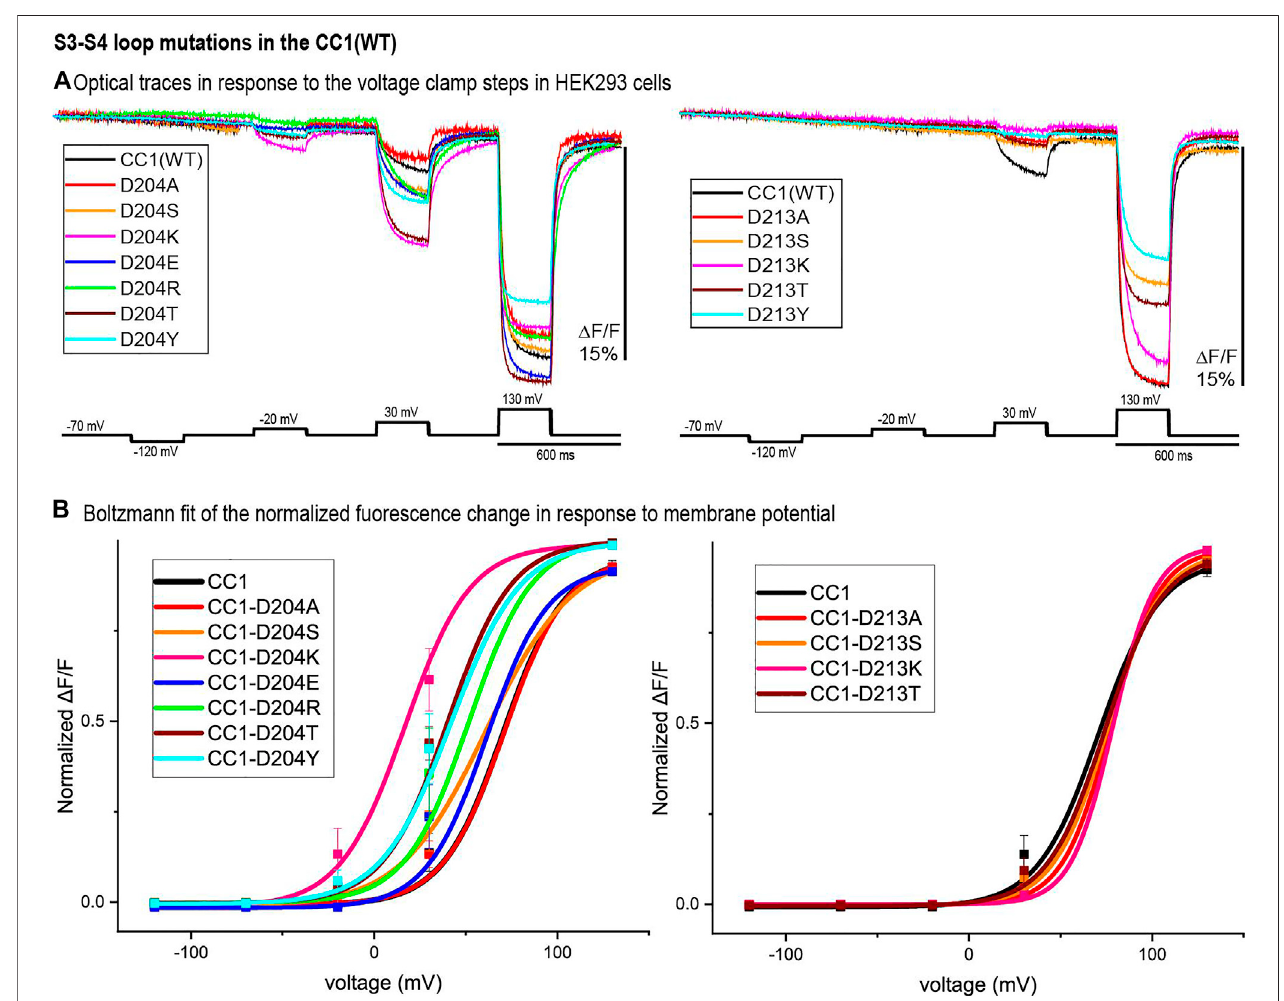
FIGURE4| S3-S4loopmutationsintheCC1 startingconstruct. (A) .HEK293cellsexpressingtheCC1(WT)orCC1(WT)withanS3-S4loopmutantwerevoltage- clamped.The traces are fl uorescent optical signals (average of three cells) from plasma membranewithouttemporal fi ltering. Each cell isthe average of16trials. Images were recorded at a frame rate of 500 fps. (B) . The voltage- fl uorescence curve of the normalized optical signal for the CC1 construct and its derivative probes with single mutation at S3-S4 loop ( n = 3 for all constructs).